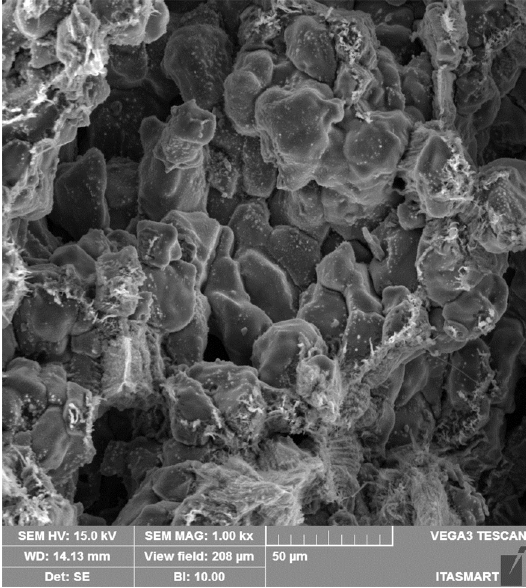
Figure 12. SEM image of the surface fracture of the AA5083-O fractured in the tensile test with a strain rate of 5.10 -5 s -1 at a temperature of